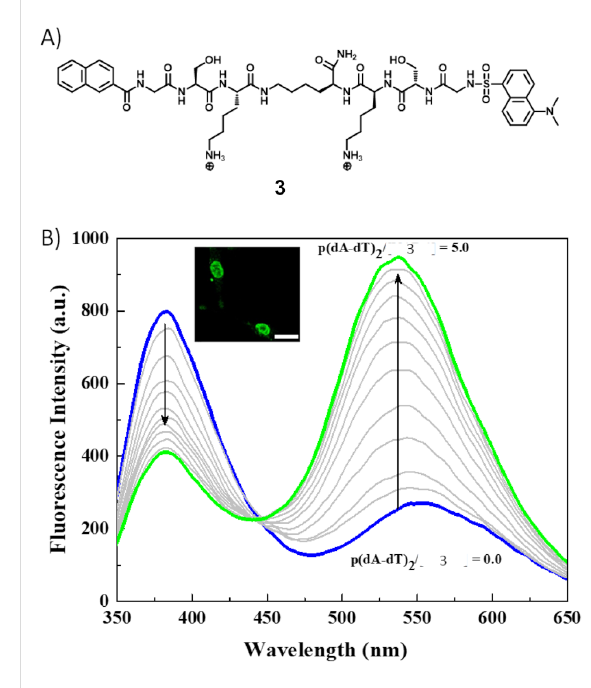
Figure 4: A) Molecular structure of 3 ; B) fluorescence emission spec- tra for the titration of a 10 μ M solution of 3 with p(dA·dT) 2 in 10 mM HEPES buffer (pH 7.4) (with base pair/ 3 molar ratios ranging from 0 to 5.0), inset: Nuclei of A549 cells stained with 3 . Reproduced from [33] with permission from The Royal Society of